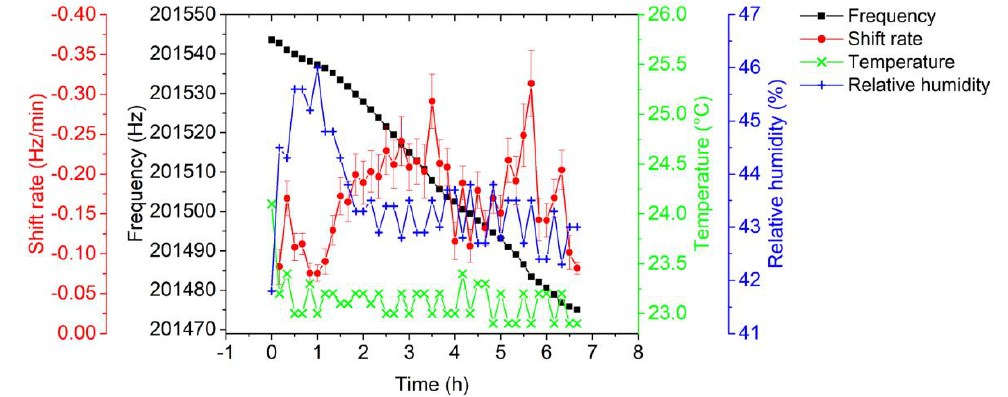
Figure 10. Resonance frequency of the EtPCS tracked by the LabVIEW-based PLL in real-time and the corresponding frequency-shift rate at 10-min sampling of carbon nanoparticles under stabilized ambient conditions ( T = 23.2 ± 0.19 C; rH = 43.5 ± 0.59%).